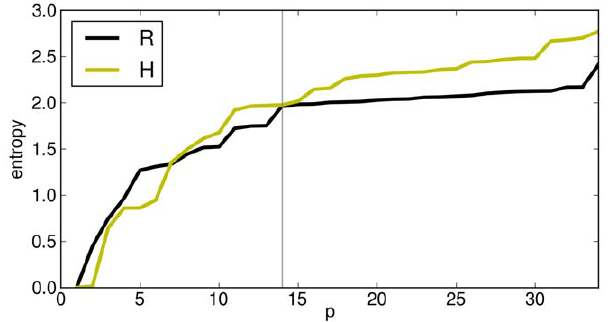
Figure 1. Looking for optimal p in clustering. Clustering entropy for Hamming and Rohlin distance at different p values for H3N2. The plateau, in Rohlin, suggests an optimal and stable result for the